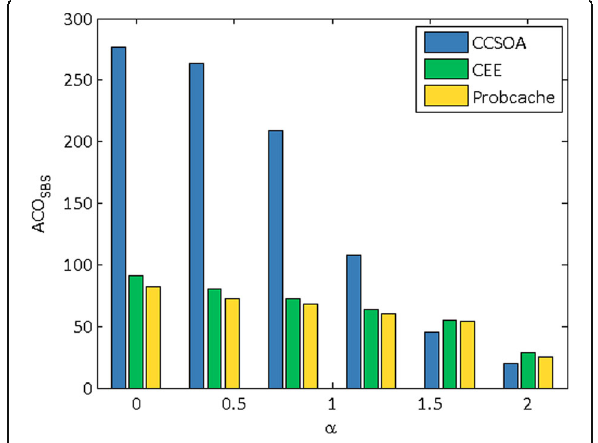
Fig. 26 Impact of Zipf parameter to ACO in the SBS level in ER